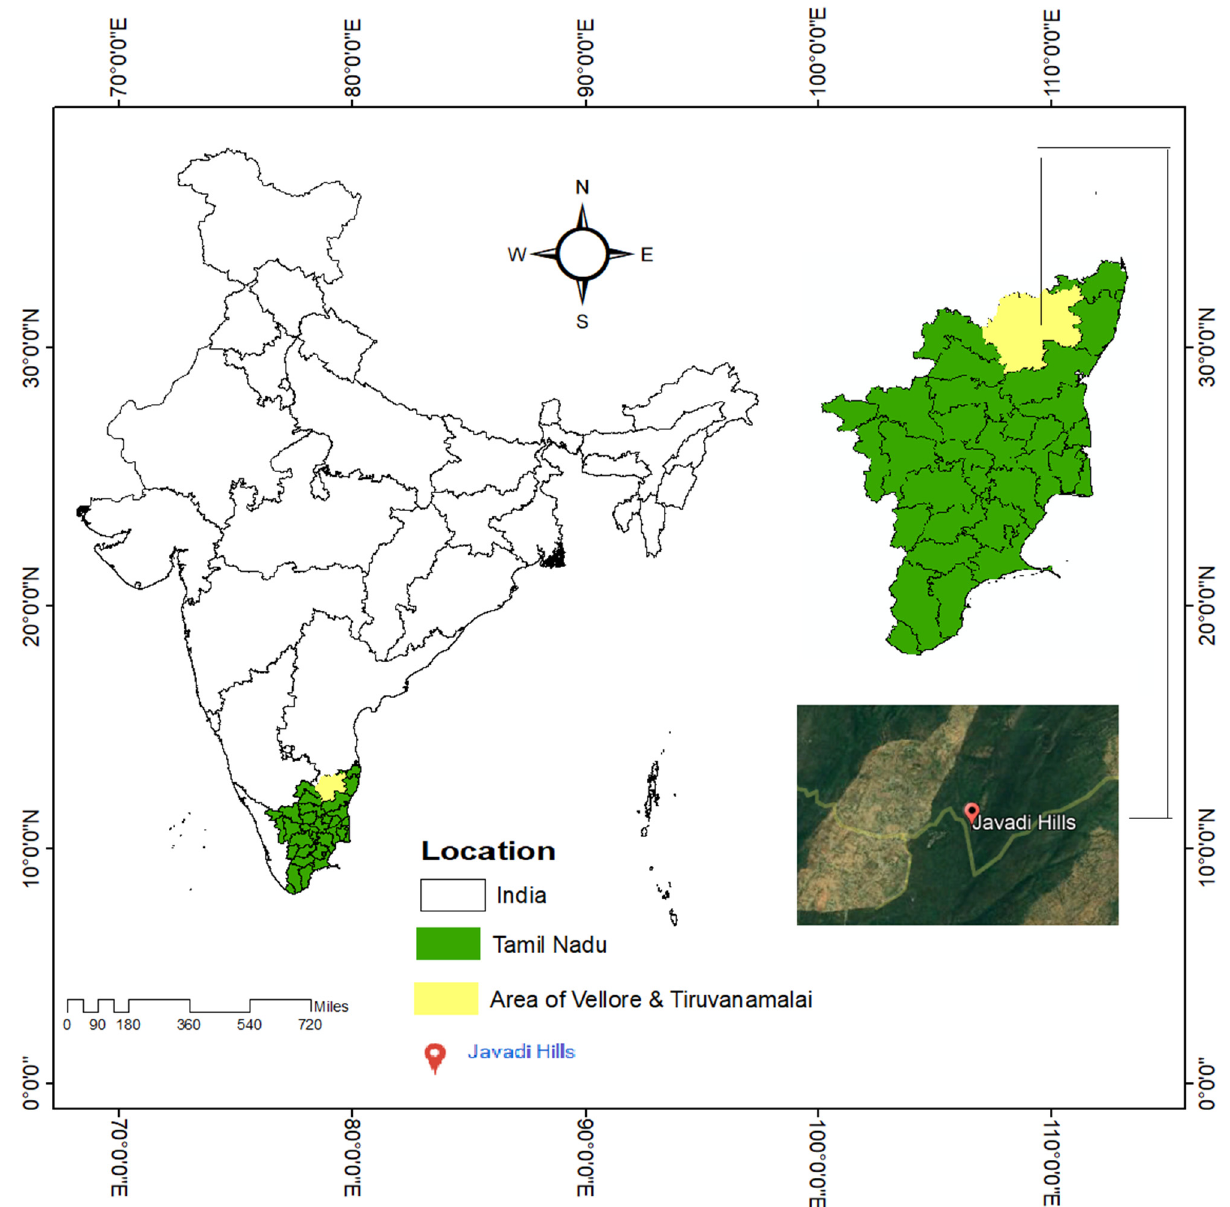
Figure 1. Study Area—Javadi Hills, India.